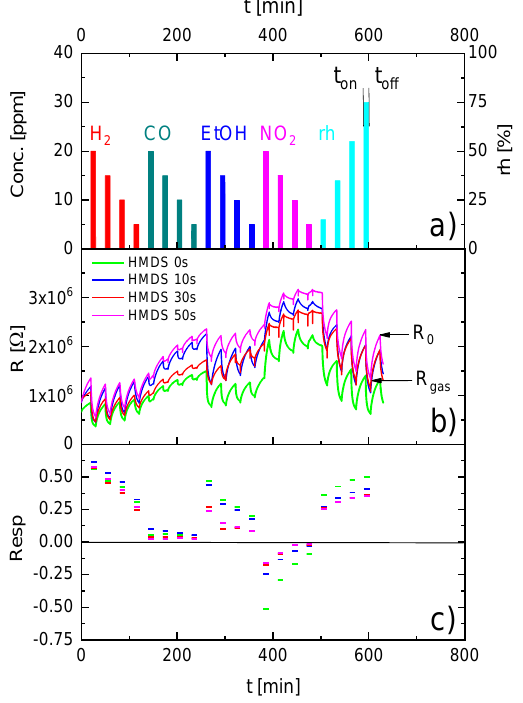
Figure 2. ( a ) Test gas exposure sequence. Test gases were supplied in gas flows of 200 sccm/min of dry synthetic air (SA); ( b ) gas-induced resistance changes; ( c ) relative resistance responses after different-length HMDS treatments.